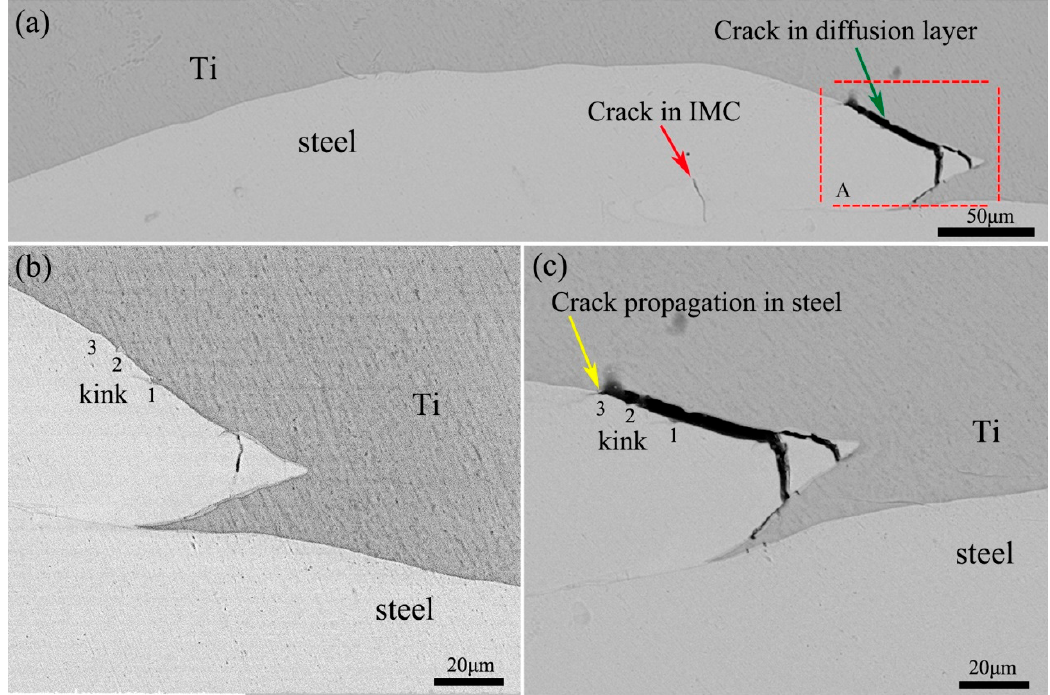
Figure 11. SEM (BSE) micrographs of the specimen after three-point bending test ( a ) and detailed micrographs before ( b ) and after ( c ) bending test.